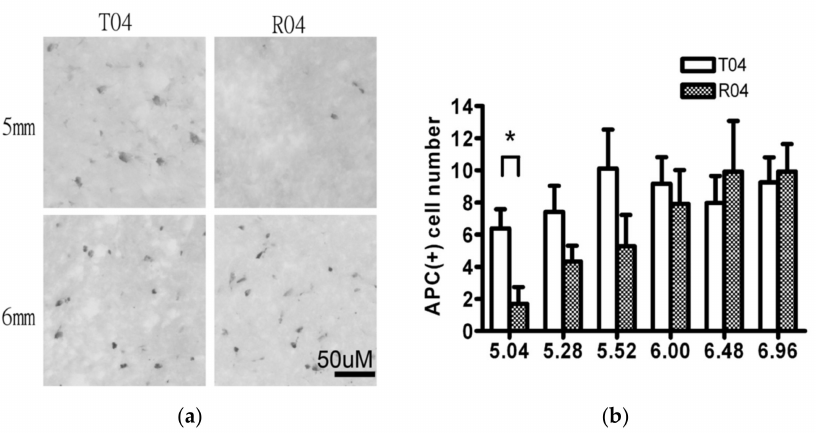
Figure 8. ( a ) The APC+ cells within the dorsal funiculus at 5 mm (upper panel) and 6 mm (lower